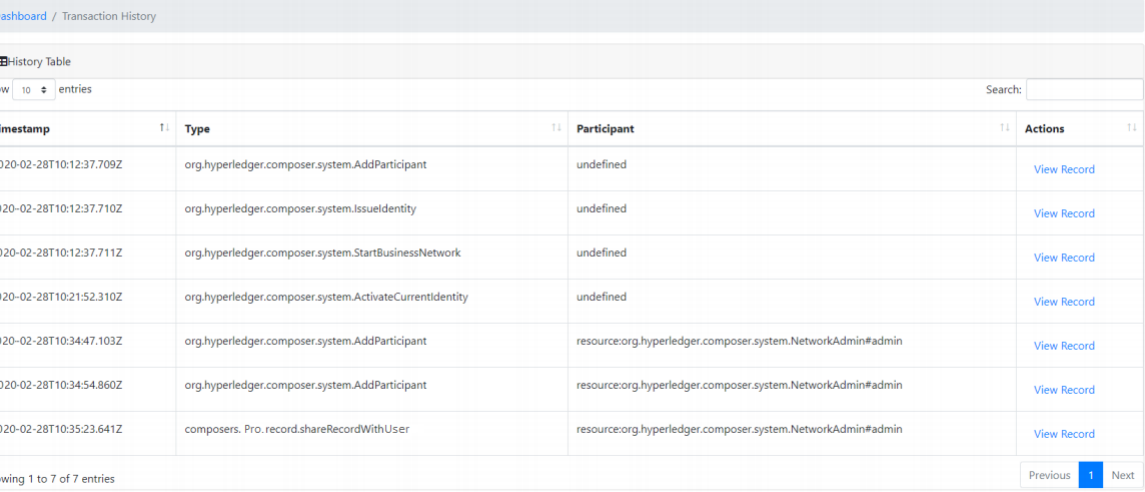
Figure 10. Transaction history of the food traceability.